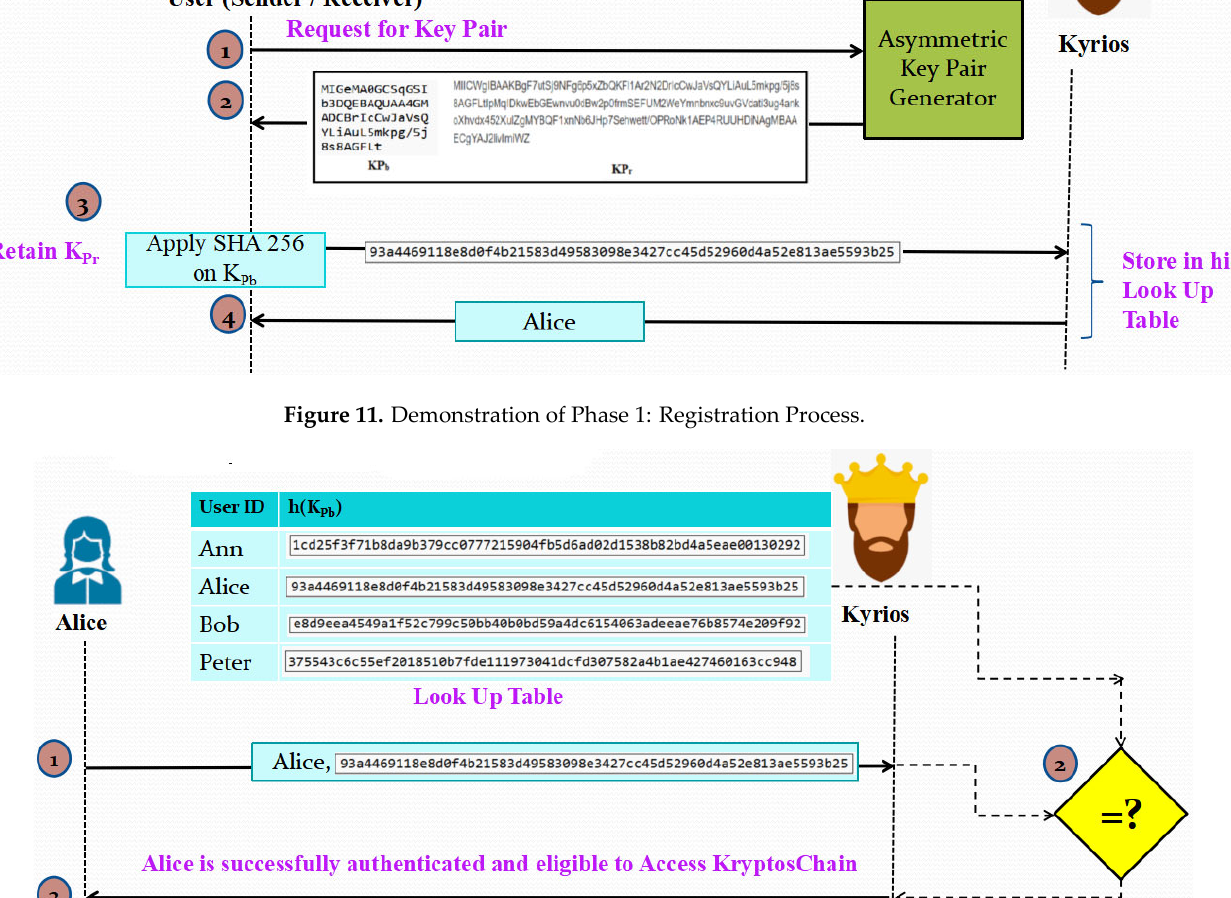
Figure 13. Demonstration of Phase 3: Genesis Block Generation Process. 4.2.4. Phase 4: Receiver Authentication The intended receiver of Alice is also similarly validated by Kyrios and this step is illustrated in Figure 14.